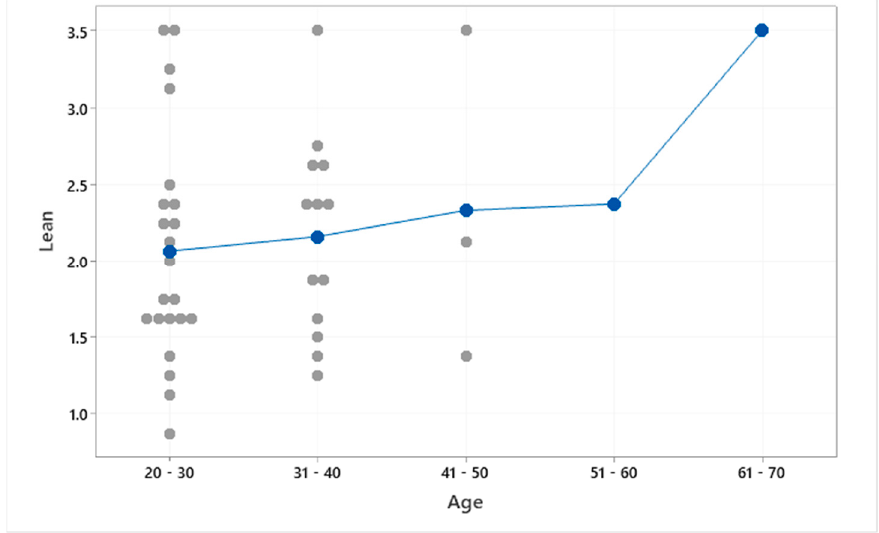
Figure 17. Individual value plot of lean vs. age .